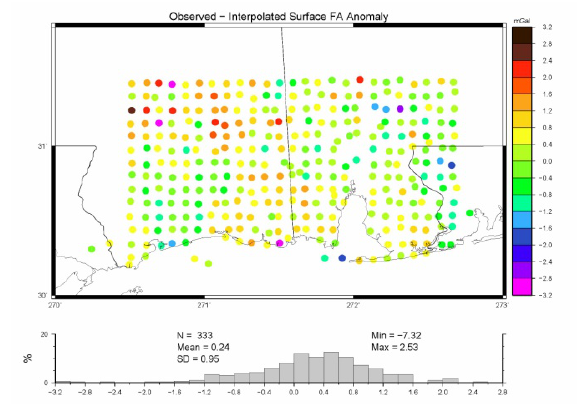
Figure 7. Residual gravity anomaly distribution.